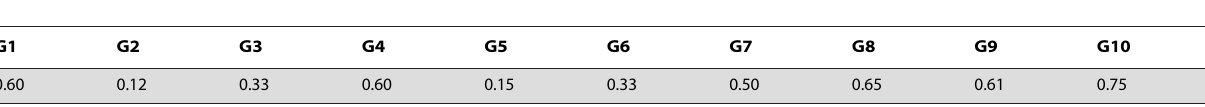
Table 5. Wild type steady state in Dream4 data set.